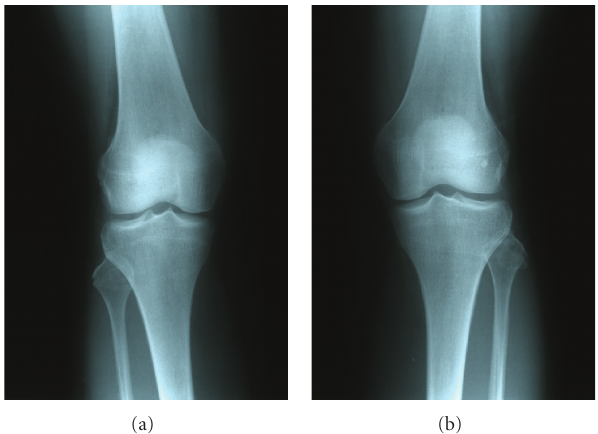
Figure 5: Anteroposterior radiographs of both knees 6 months after trauma. Fractures of both fibular heads are fully